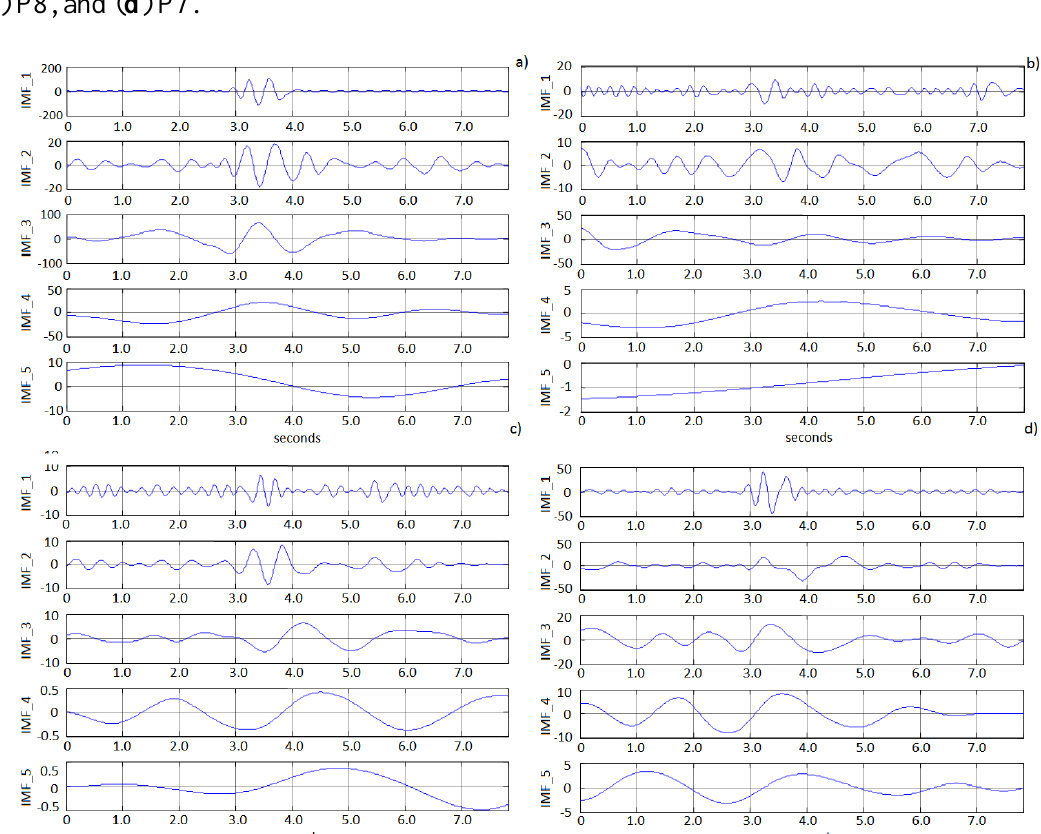
Figure 6. EMD decomposition from four different electrodes near AF3. ( a ) FC5, ( b ) FC6, ( c ) P8, and ( d )